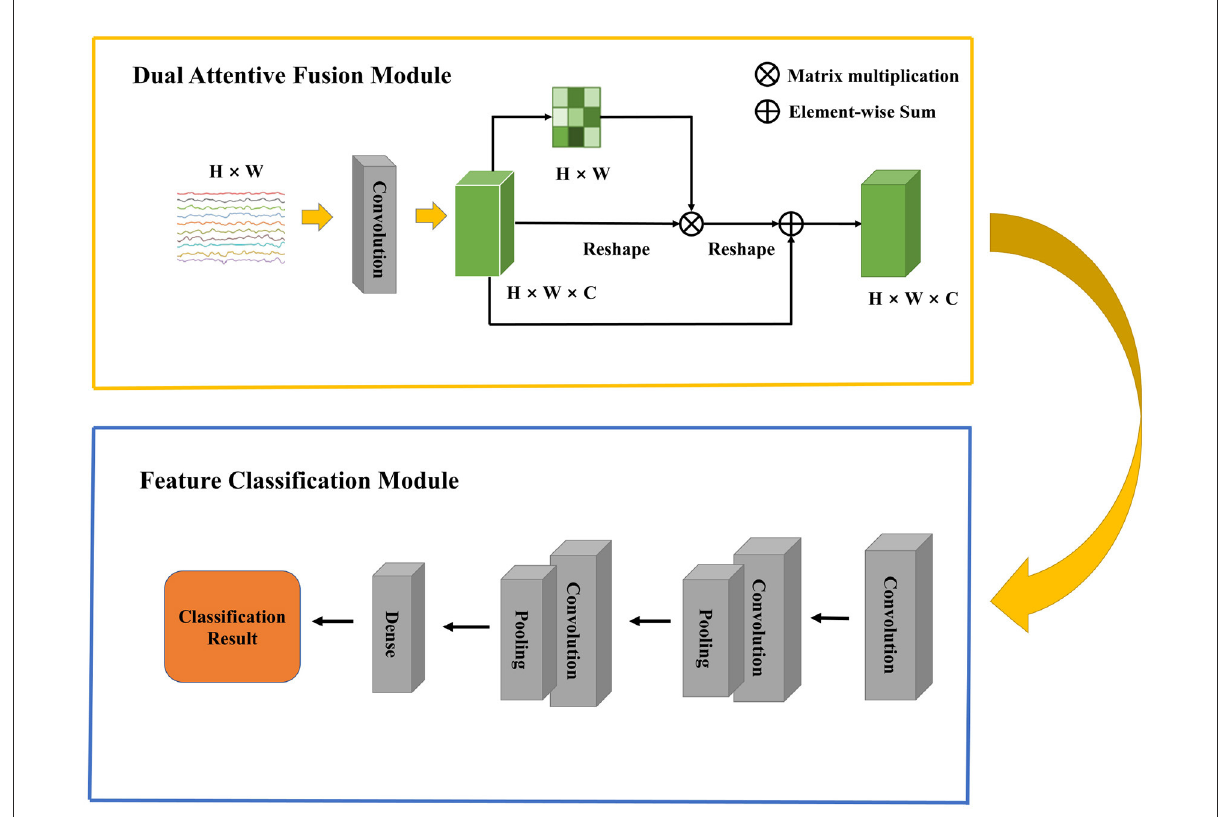
FIGURE1 An overview of the Dual Attentive Fusion